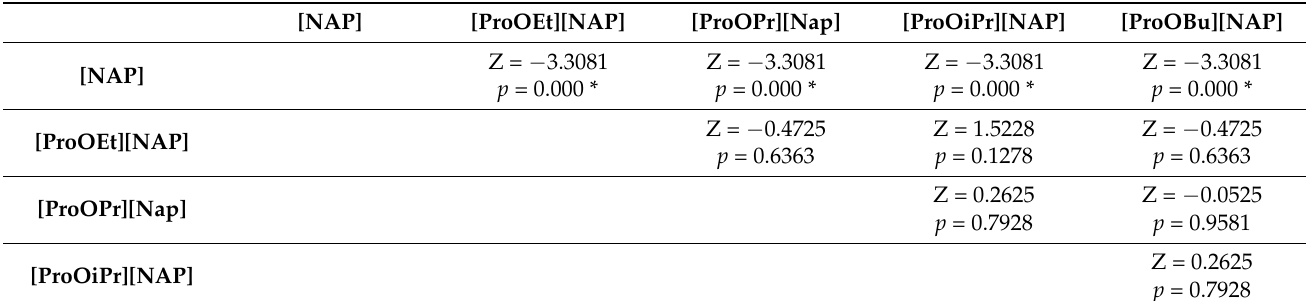
Table 8. Significant differences in the cumulative mass between all analyzed compounds, taking into account all time points during the entire 24 h permeation, were estimated by the Mann–Whitney test.